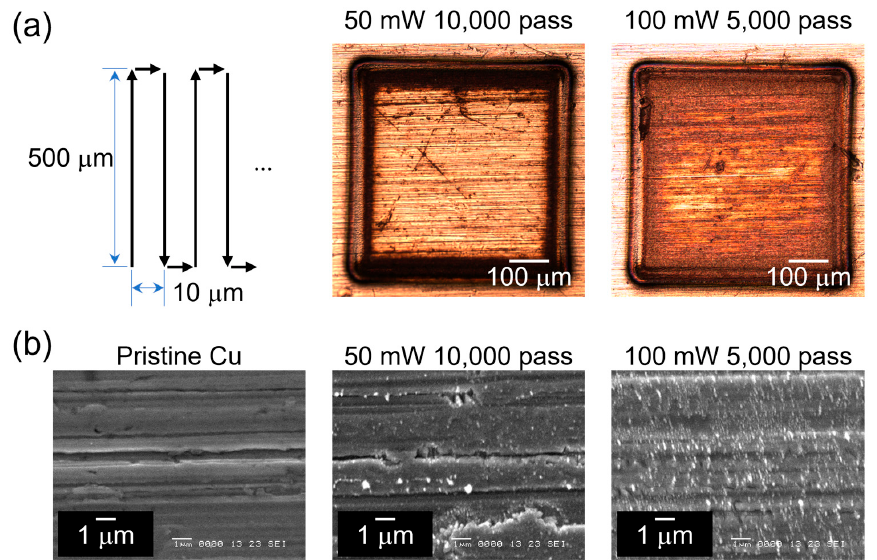
Figure 2. ( a ) Laser scanning pattern and images of the laser ‐ irradiated samples. ( b ) SEM images of pristine, 50 mW ‐ , and 100 mW ‐ irradiated samples.